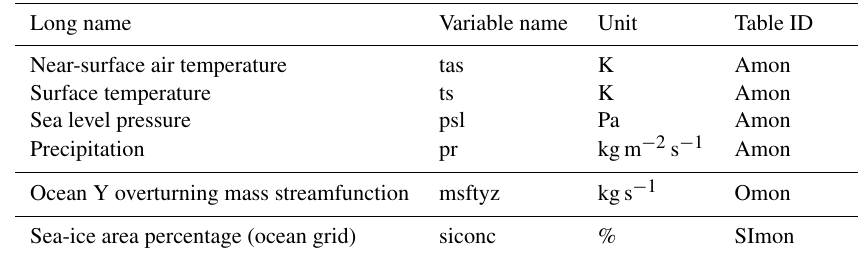
Table 1. List of variables in the piControl , midHolocene and lig127k simulations that were downloaded from the ESGF. Long